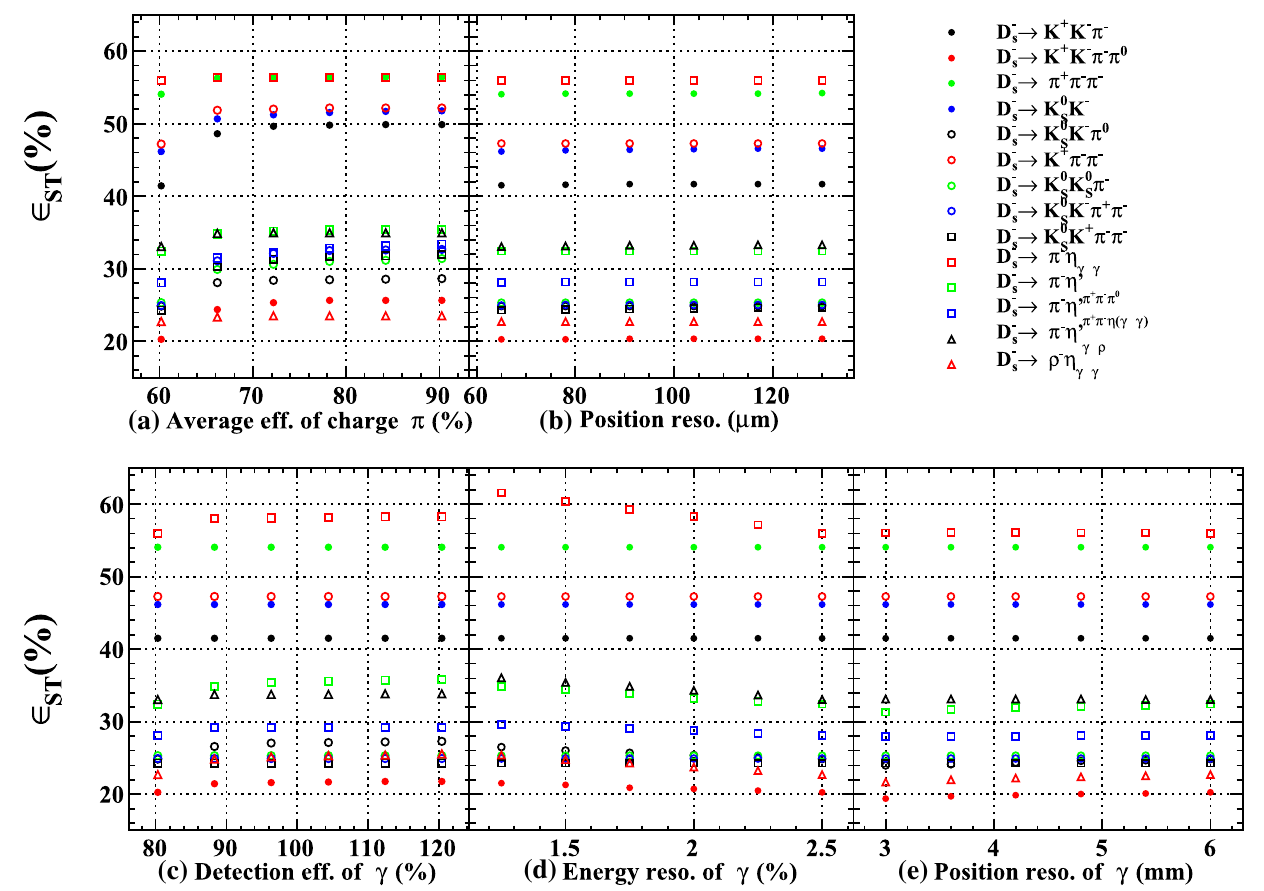
c Shows the detection efficiency of photons in 200 MeV. d Shows the energy resolution of photon at 1 GeV. e Shows the position resolution of photon at 1 GeV